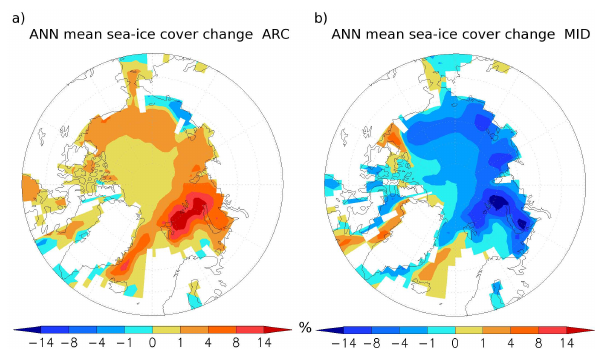
Fig. 10. Annual mean sea-ice cover change (in %) for (a) the ARC- CONTROL and (b) the MID-CONTROL. White areas are not sig- nificant on a 95%